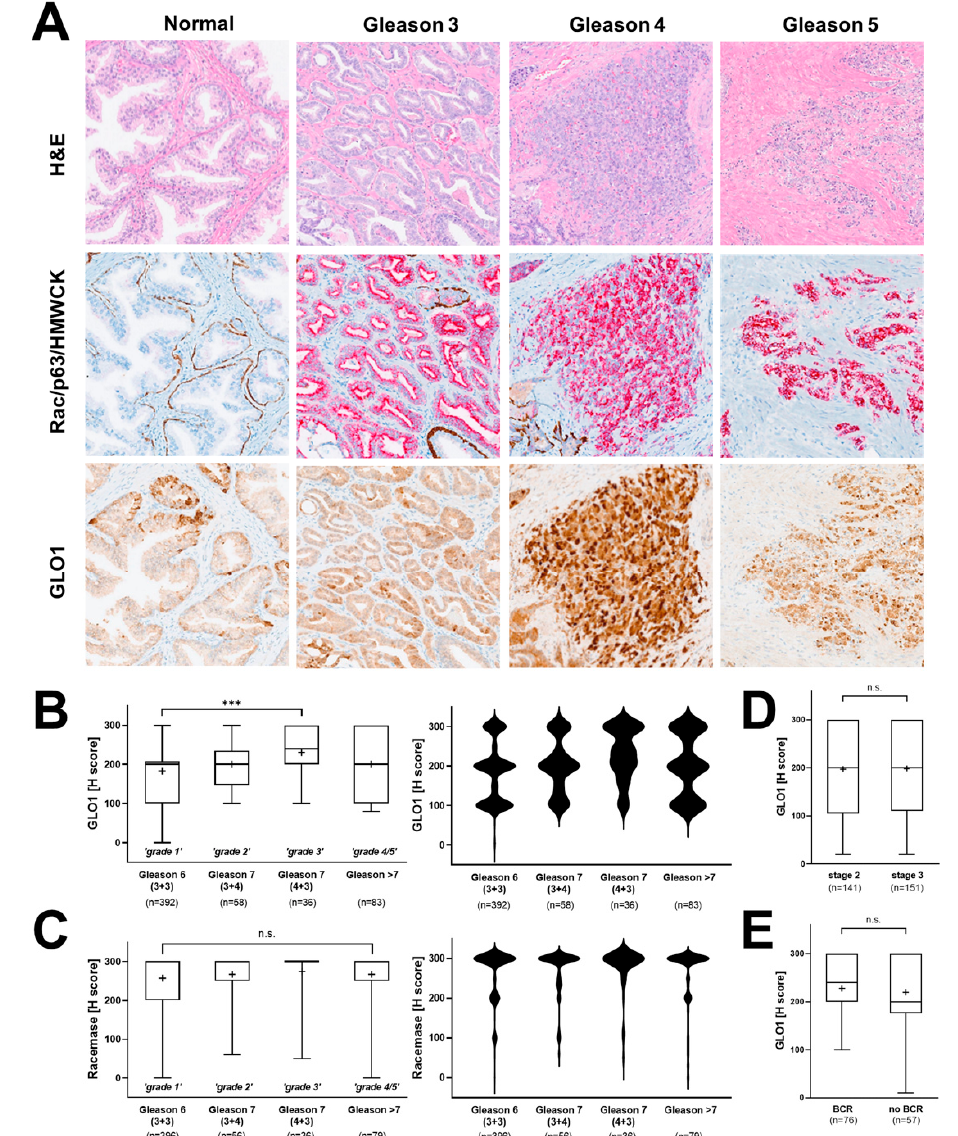
Figure 3. Association of GLO1 immunohistochemical staining with clinical parameters of PCa. ( A ) Representative images depicting different Gleason patterns from the tissue cohort; H&E (left col- umn); Rac/p63/HMWCK (middle column); GLO1 (right column). ( B ) GLO1 expression as a function of Gleason grade (left: box and whisker plot; right: violin plot). ( C ) Racemase detection as a function of Gleason grade (left: box and whisker plot; right: violin plot). ( D ) GLO1 immunohistochemical detection as a function of pathologic stages 2 (organ confined) and 3 (capsular penetration). ( E ) GLO1 detection as a function of biochemical recurrence (BCR). Statistical analysis of tissue data sets was performed using the Mann–Whitney and Kruskal–Wallis tests (*** p < 0.0005); ‘+’ signifies the